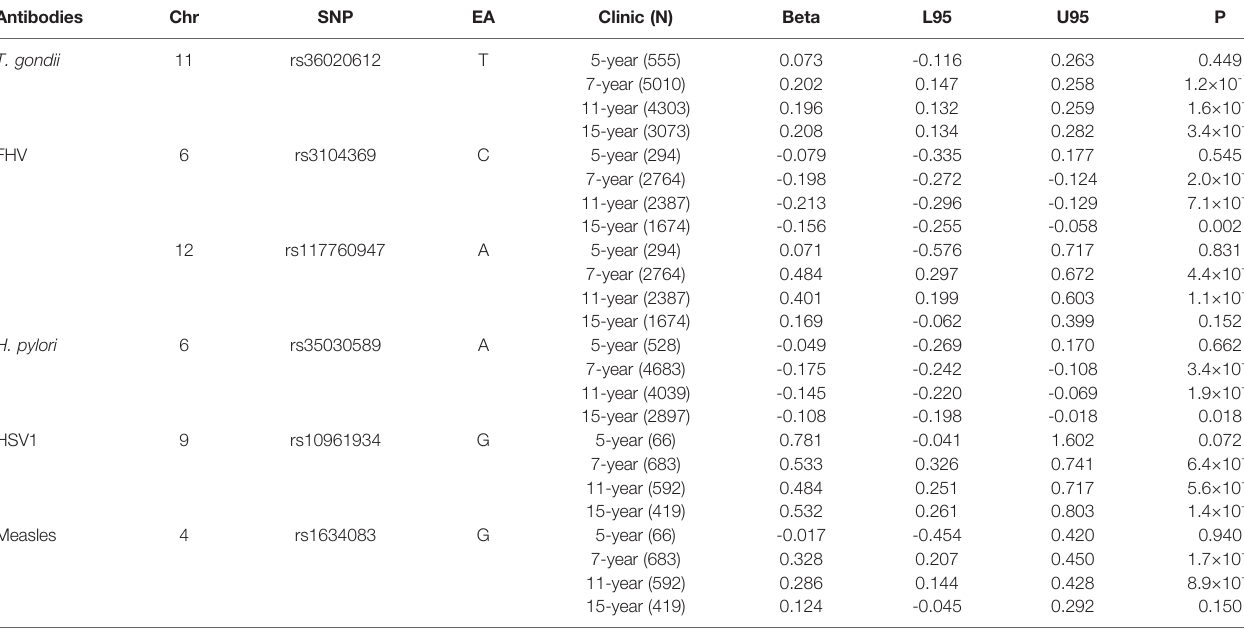
TABLE 5 | Associations identi fi ed using ALSPAC seven-year clinic antibody data (P < 1.0×10 -6 ) that also showed evidence for association ( P < 4.3×10 -4 ) at other timepoints. Antibodies Chr SNP EA Clinic (N)